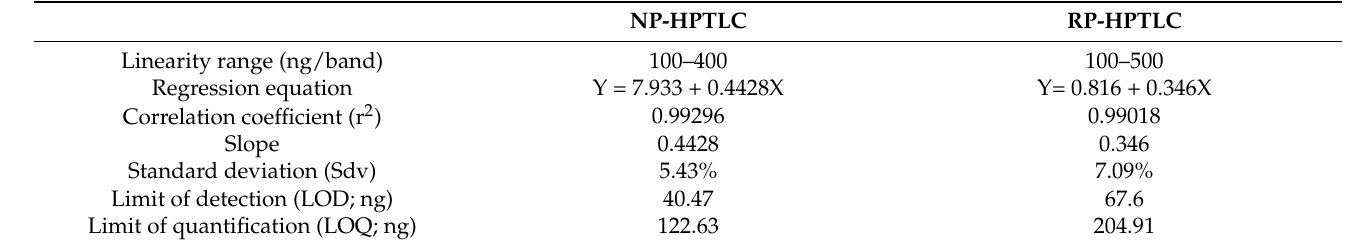
Table 3. Linear regression data with LOD and LOQ for IR3G in NP ‐ and RP ‐ HPTLC ( n = 3).